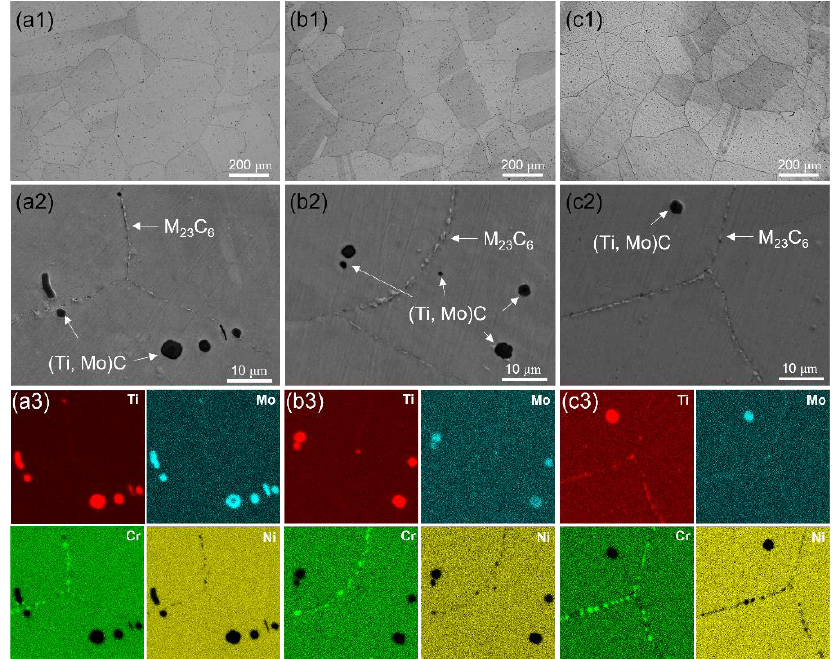
Figure 4. ( a1 , b1 , c1 ) Optical microscopy images of the microstructure after tensile deformation at room temperature, 700 °C, and 750 °C, respectively, ( a2 , b2 , c2 ) corresponding SEM images of the microstructure, ( a3 , b3 , c3 ) SEM-EDS maps of Ti, Mo, Cr, Ni of the entire region in ( a2 , b2 , c2 ), respectively.